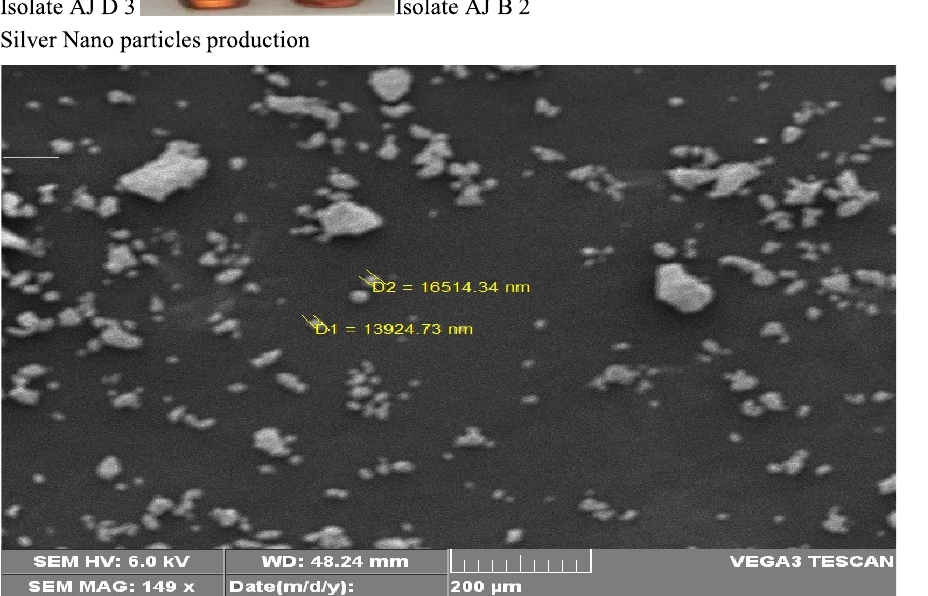
Fig. 2. Electron micrograph of silver